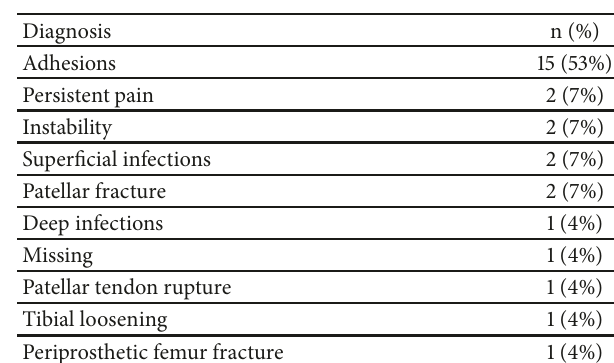
Table 2: Postoperative complications.